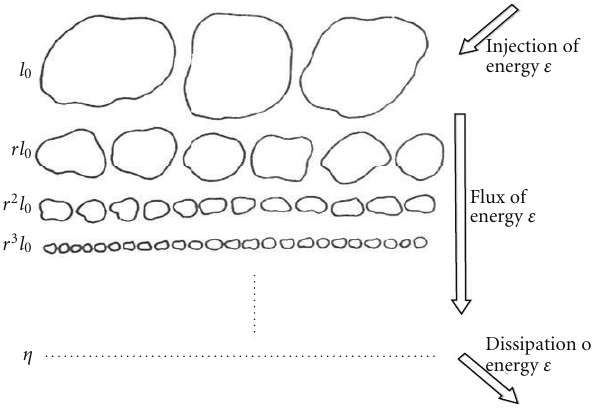
Figure 40: Sketch of Richardson cascade process